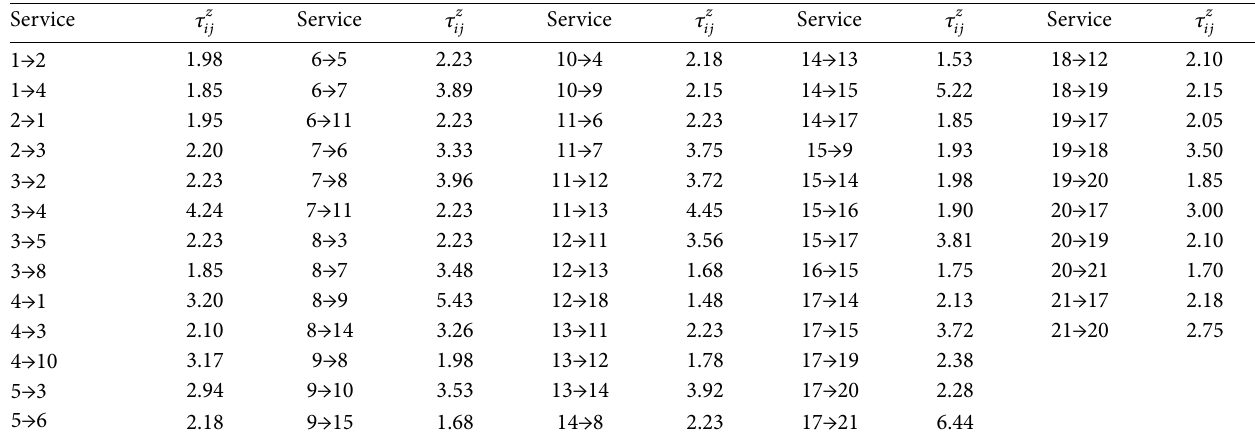
Table 5: Operated local train services and